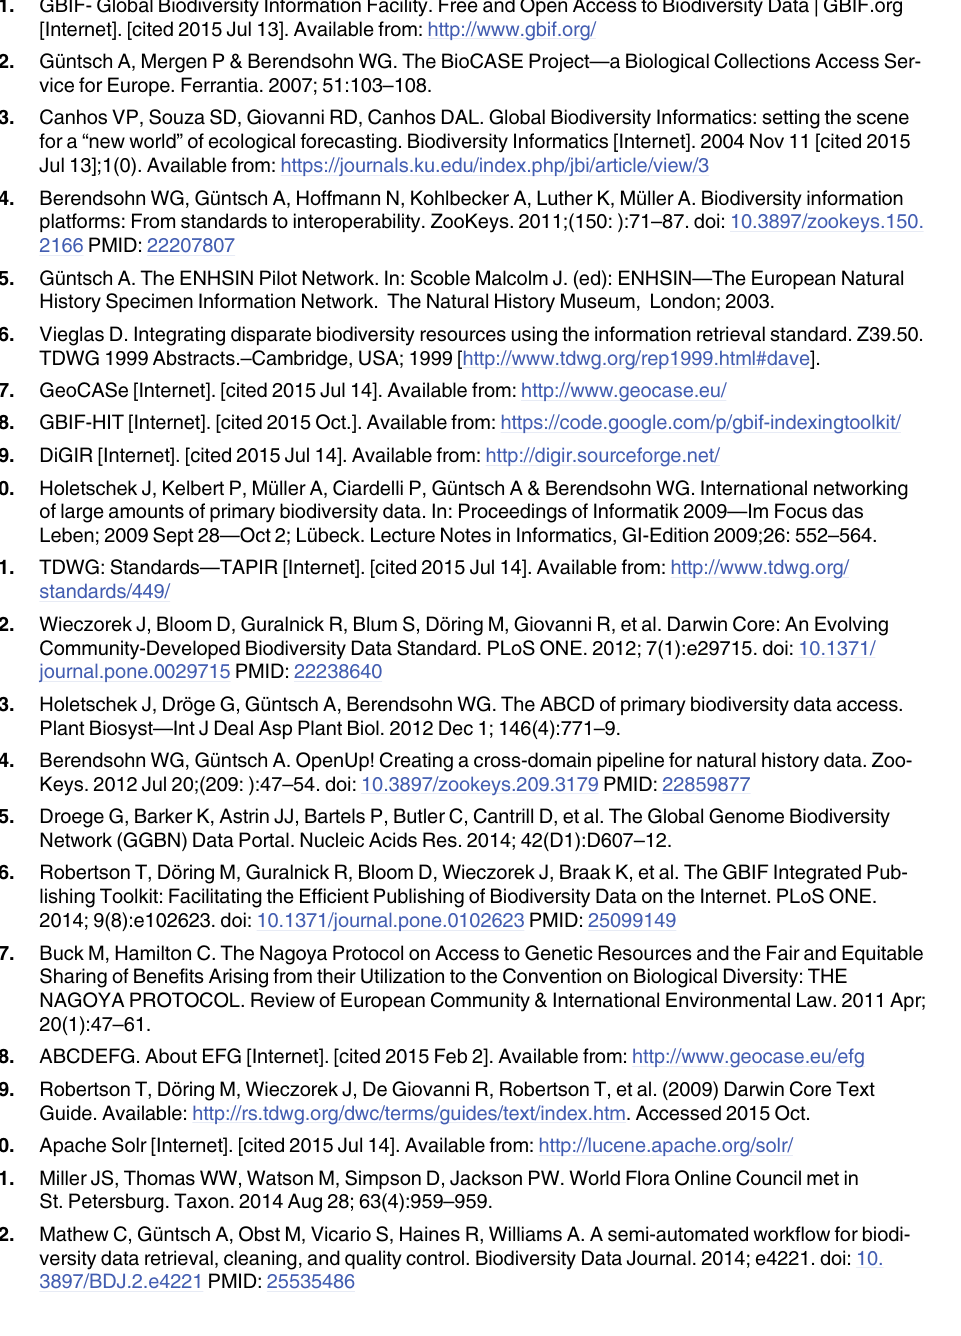
PLOS ONE | DOI:10.1371/journal.pone.0142240 November 6,